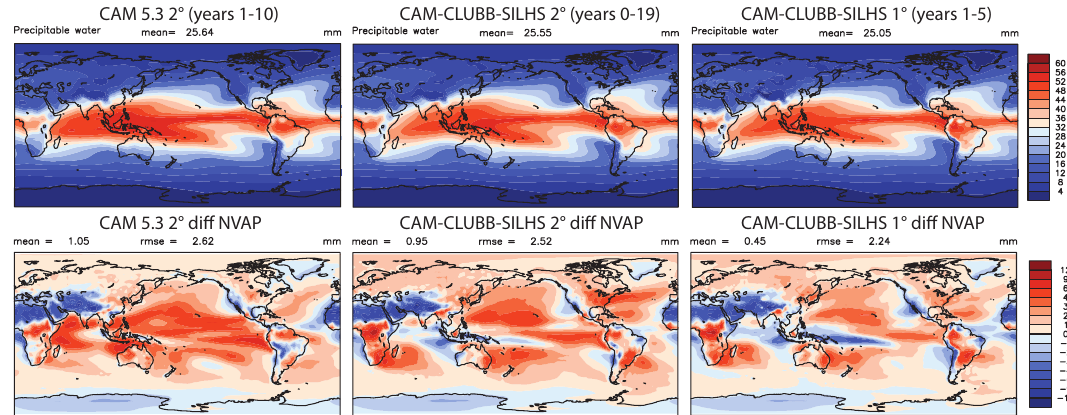
Figure 3. Total column water vapor field for CAM 5.3 (left), CAM-CLUBB–SILHS 2 degree (center), and CAM-CLUBB–SILHS 1 degree (right). The difference from National Aeronautics and Space Administration (NASA) Water Vapor Project (NVAP) satellite observations (model − obs) is shown in the second row. CAM-CLUBB–SILHS reduces the overall moist bias seen in CAM 5.3.